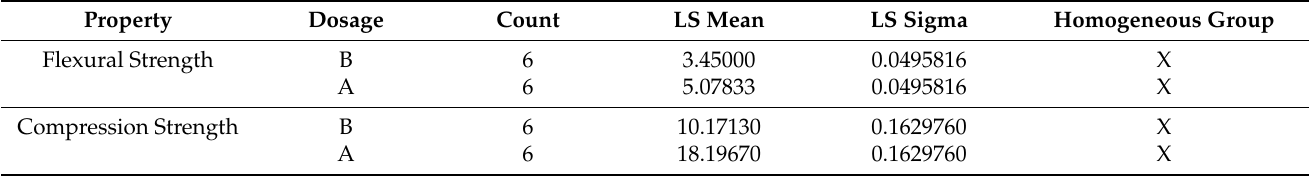
Table 8. Multi-range test for flexural and compressive mechanical strengths (MPa) considering the cement/aggregate ratio. Property